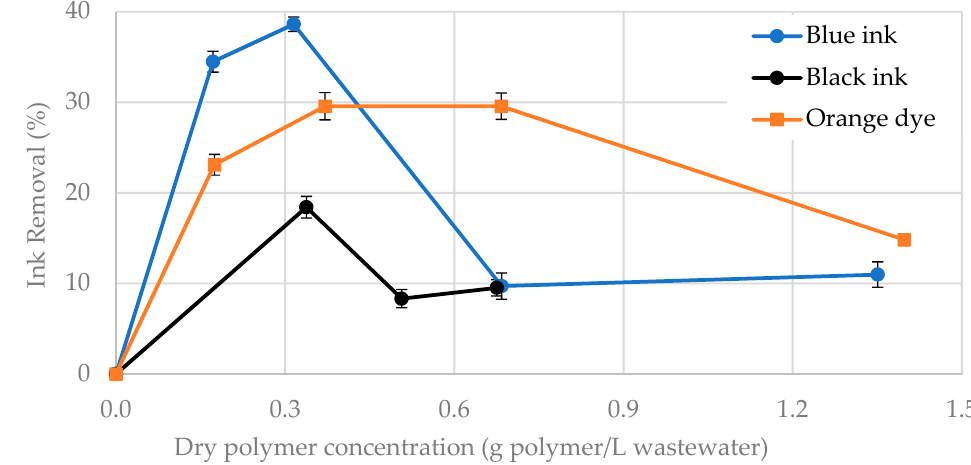
Figure 13. Ink and dye removal with CNF-g-CH in gel phase.